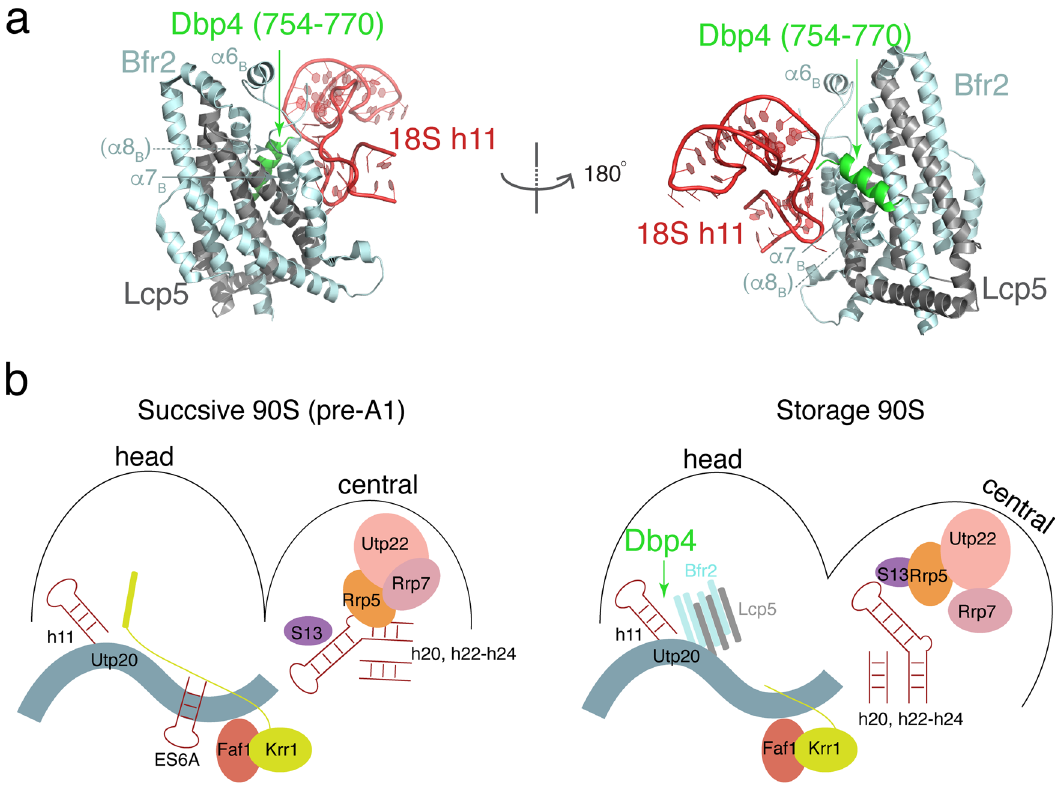
Fig. 4 A proposed mechanism of Bfr2-Lcp5-mediated locking of 90S involving helicase Dbp4. a Structural model of Bfr2-Lcp5-Dbp4 complex in two orientations. The C-terminal helix of Dbp4 (residues 754 – 770) is colored in green while Bfr2 is in cyan and Lcp5 in gray, respectively. b Schematic conformational transitions between the successive 90S (left) and the 90S in the storage conformation involving Bfr2-Lcp5 and Dbp4. Removal or dissociation of Bfr2-Lcp5 complex by Dbp4 could trigger stabilization of the Krr1 C-terminal helix and closing of the central